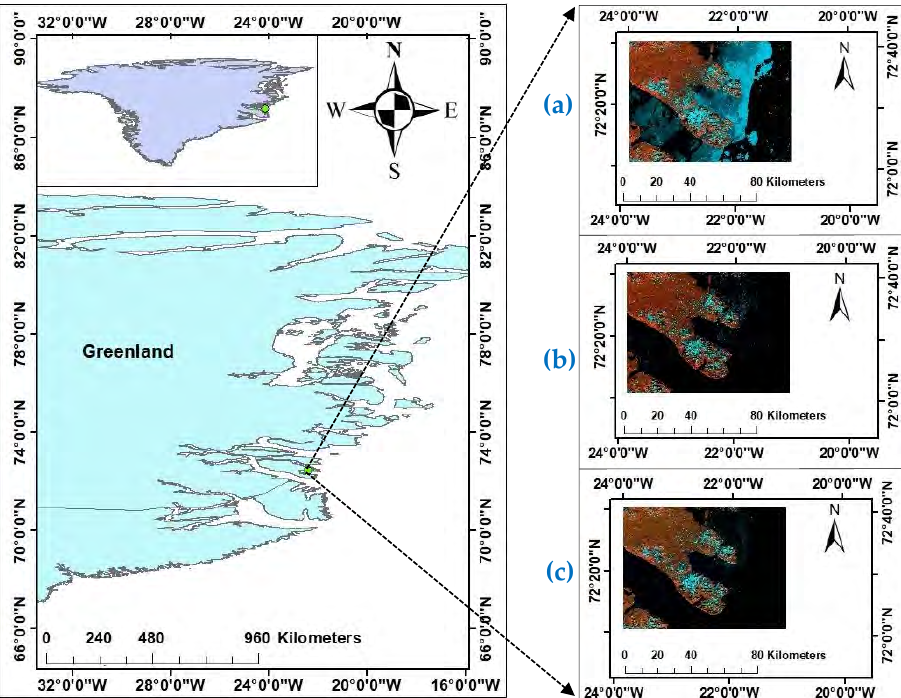
Figure 2. Location of the Greenland area under study and the false-color composite images used to visualize the amount of snow cover. Left panel represents the precise location of the area. Right panels show the false color composite images using the green, NIR, and SWIR-2 bands of this region for ( a ) Landsat 5 TM, ( b ) Landsat 8 OLI, and ( c ) Sentinel-2A